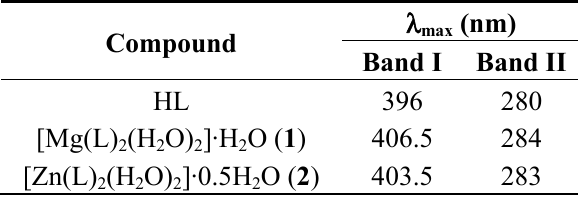
Table 4. UV-Vis data for ligand and complexes.